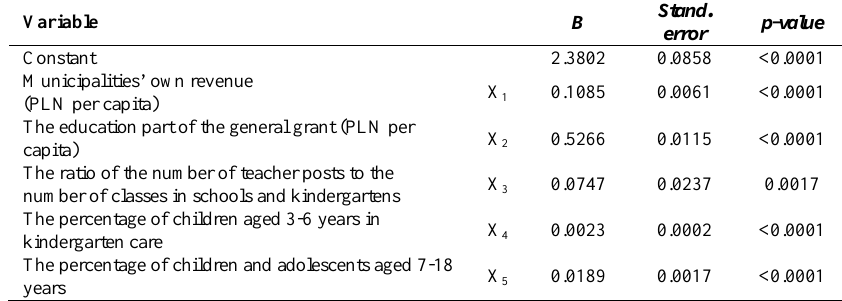
Table 2. The regression results for local shares of education funding in